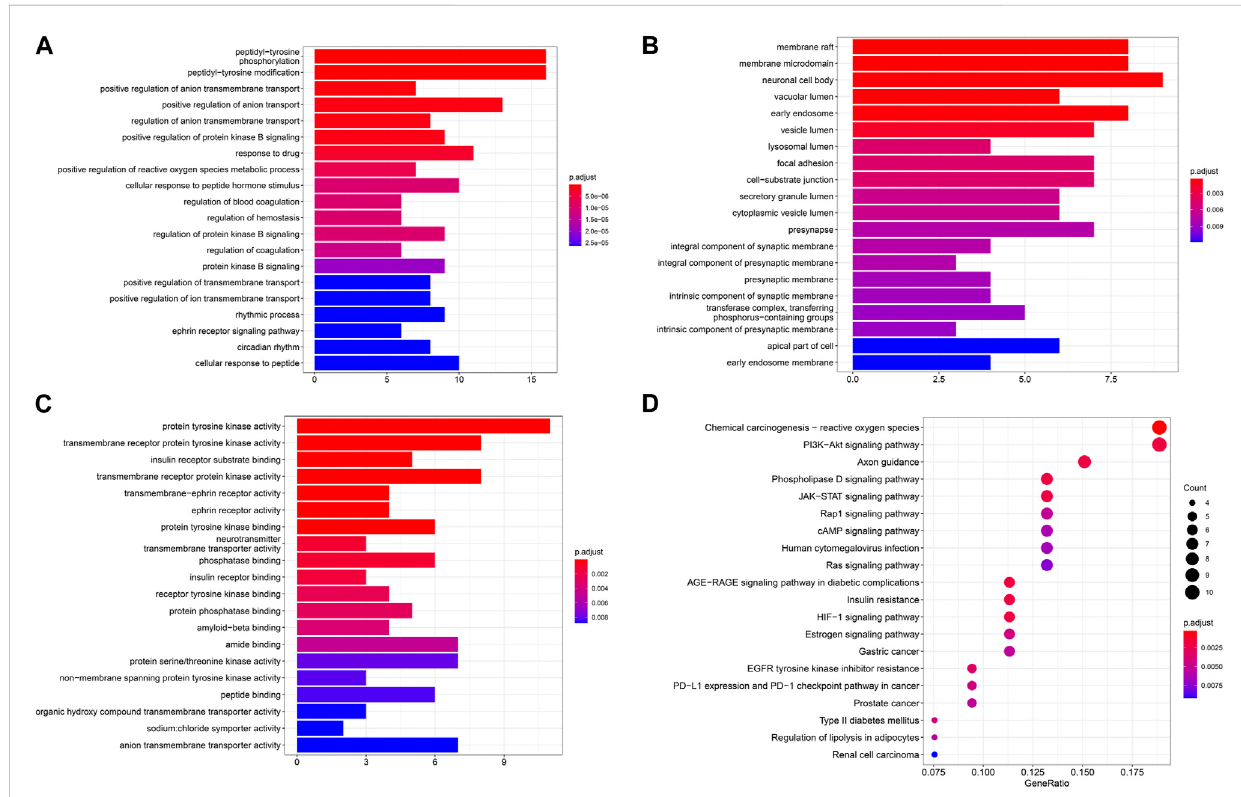
FIGURE 4 (A-D) Results of GO-BP, GO-CC, GO-MF, and KEGG pathway enrichment analysis.